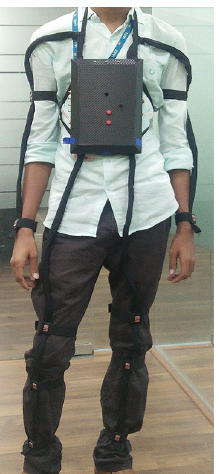
Fig. 19 A real user wearing the working